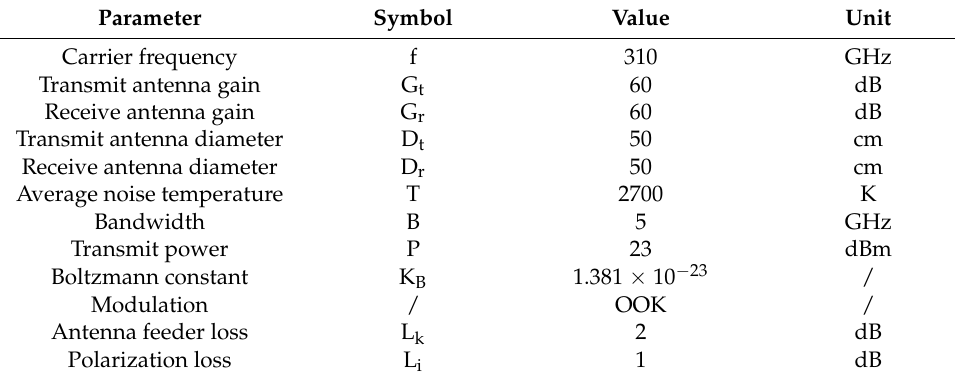
Figure 4. Block diagram of satellite terahertz communication system. Table 2. Related parameters of satellite terahertz communication system.